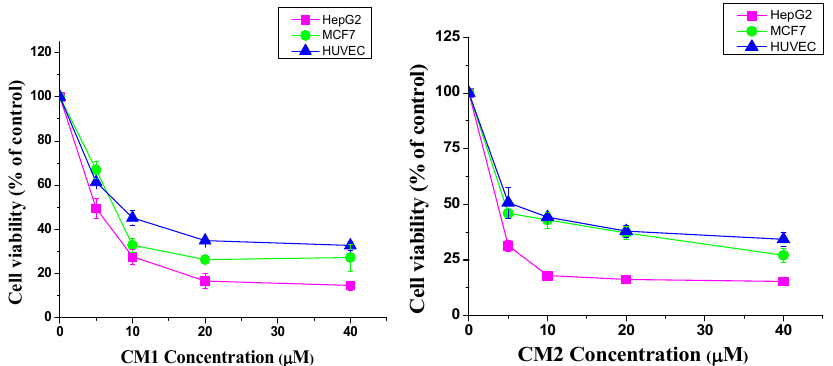
Table 1. Comparison of the IC 50 values of the chloroform extract and fractionated compounds against MCF-7, HepG2, and human umbilical vein endothelial cells (HUVEC) cell lines.